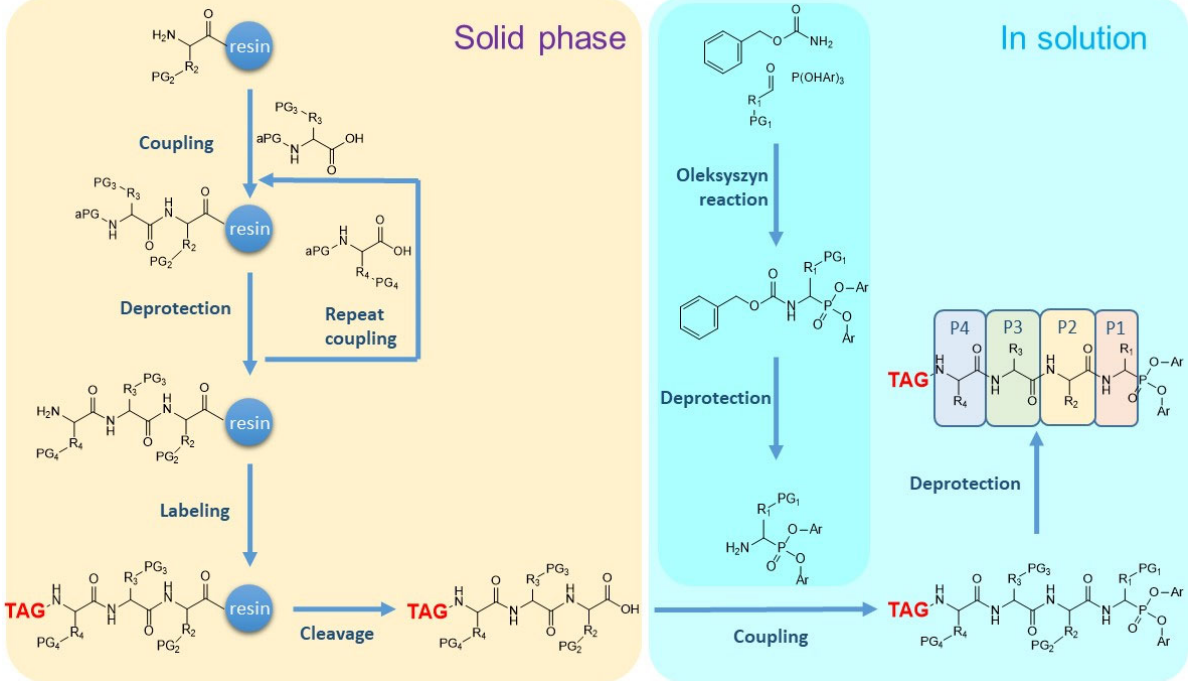
Figure 7. Schematic diagram of the synthesis of the peptidyl ‐ based phosphonate ABPs. Briefly, syn ‐